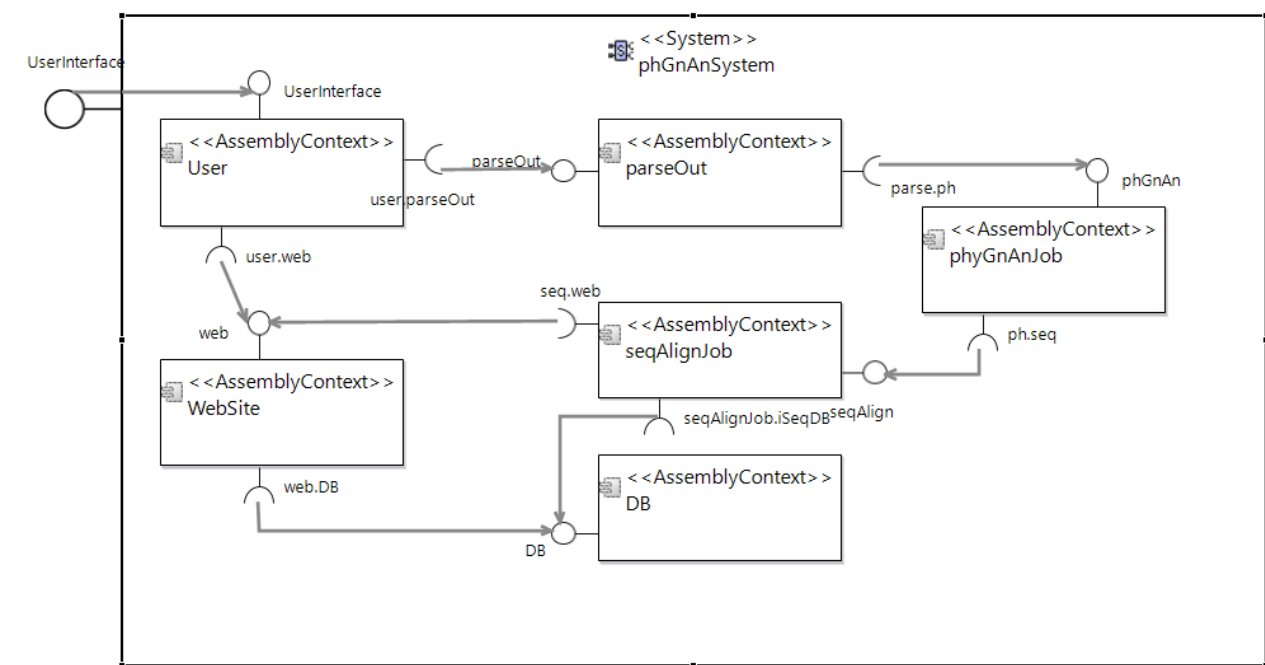
Figure 5. Assembly diagram for the phylogenetic analysis module.